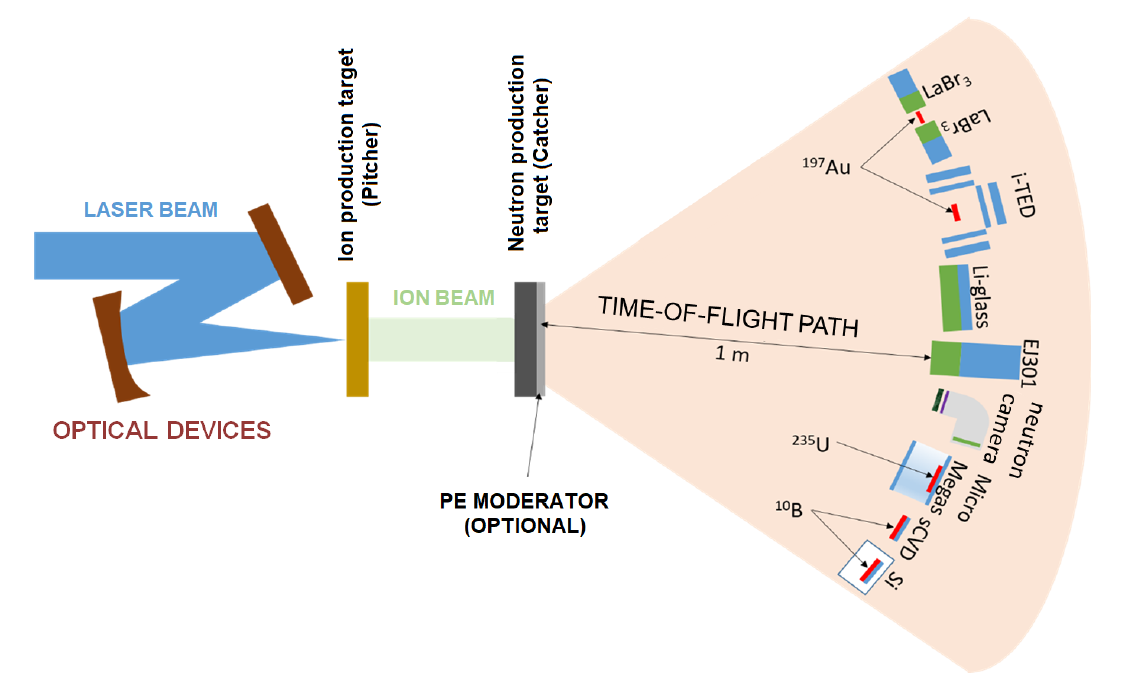
Figure 4. Pitcher-Catcher setup in the multiple detectors experiment